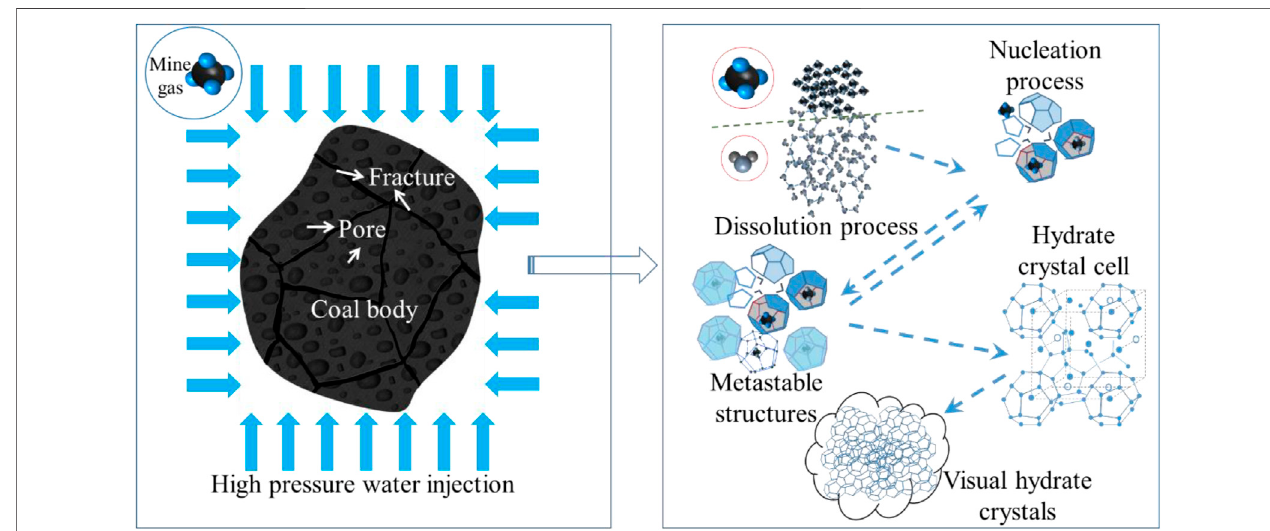
FIGURE 1 | Mine gas hydration curing reaction